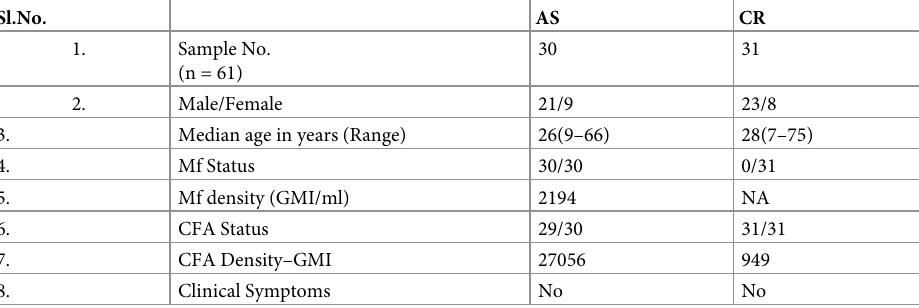
Table 2. Details and intensity of infection in two study